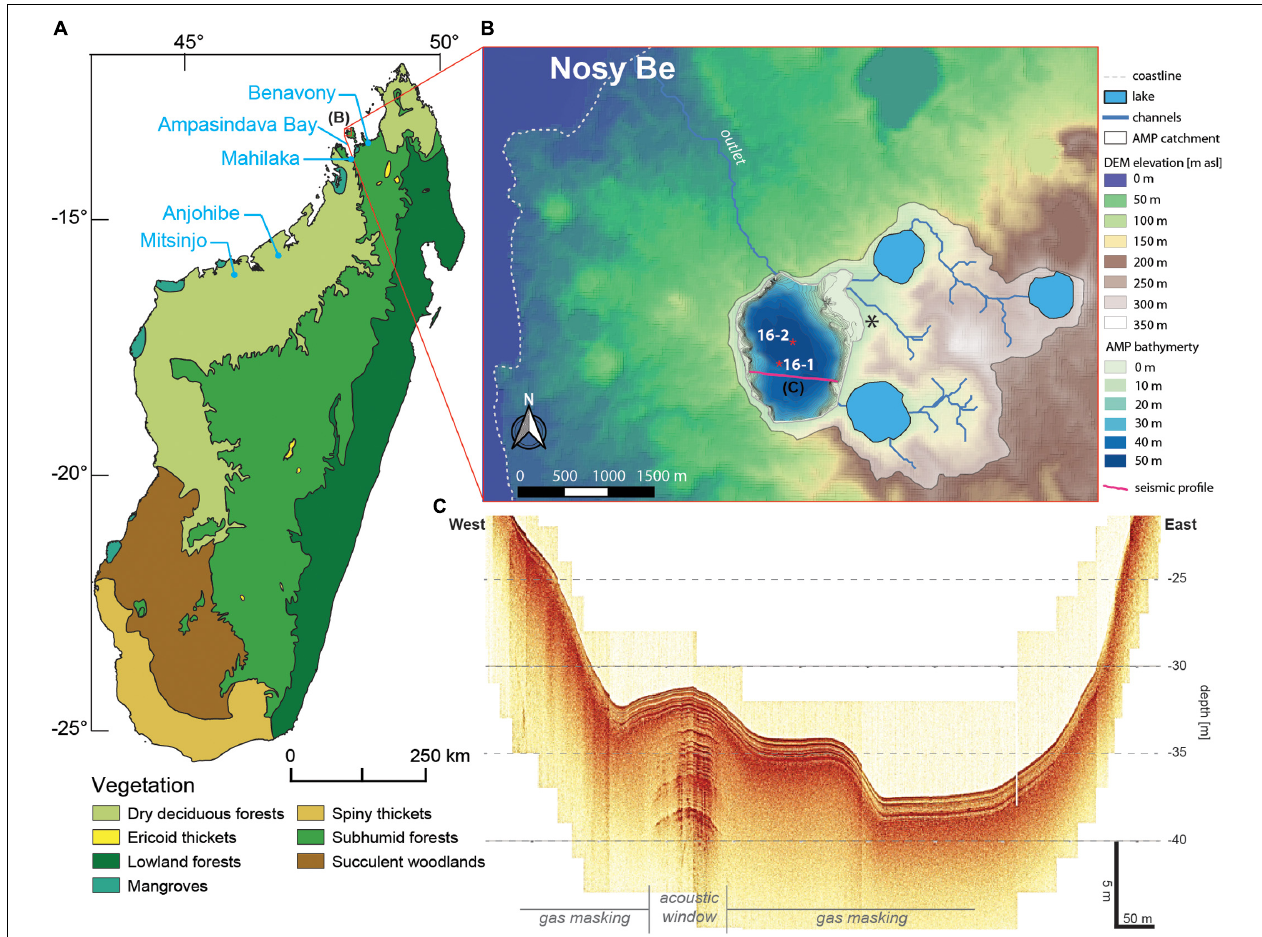
FIGURE 1 | (A) Distribution map of natural biomes in Madagascar (Olson et al., 2001). (B) Close up topography of western Nosy Be including the catchment of Lake Amparihibe (AMP), lake bathymetry, coring positions (red stars) and the location of the seismic profile in the lake (purple line) shown in panel (C) , as well as an archeological site (black asterisk; Wright and Radimilahy, 2005) (data source: DEM data derived from SRTM 1 arc-second (06/2021 – https://earthdata.nasa.gov/); bathymetric data based on interpolation of seismic profile lines; map creation with QGIS 3.1). (C) Typical seismic image of Lake Amparihibe. The uppermost ca. 1.5 m of the deposits show clearly layered sediments, further penetration is only possible within acoustic windows, which show well-layered sediments down to at least 10 m sediment depth. The limited penetration results from widely distributed gas in the sediment most likely due to decomposition of organic matter. A clear basement reflector was not